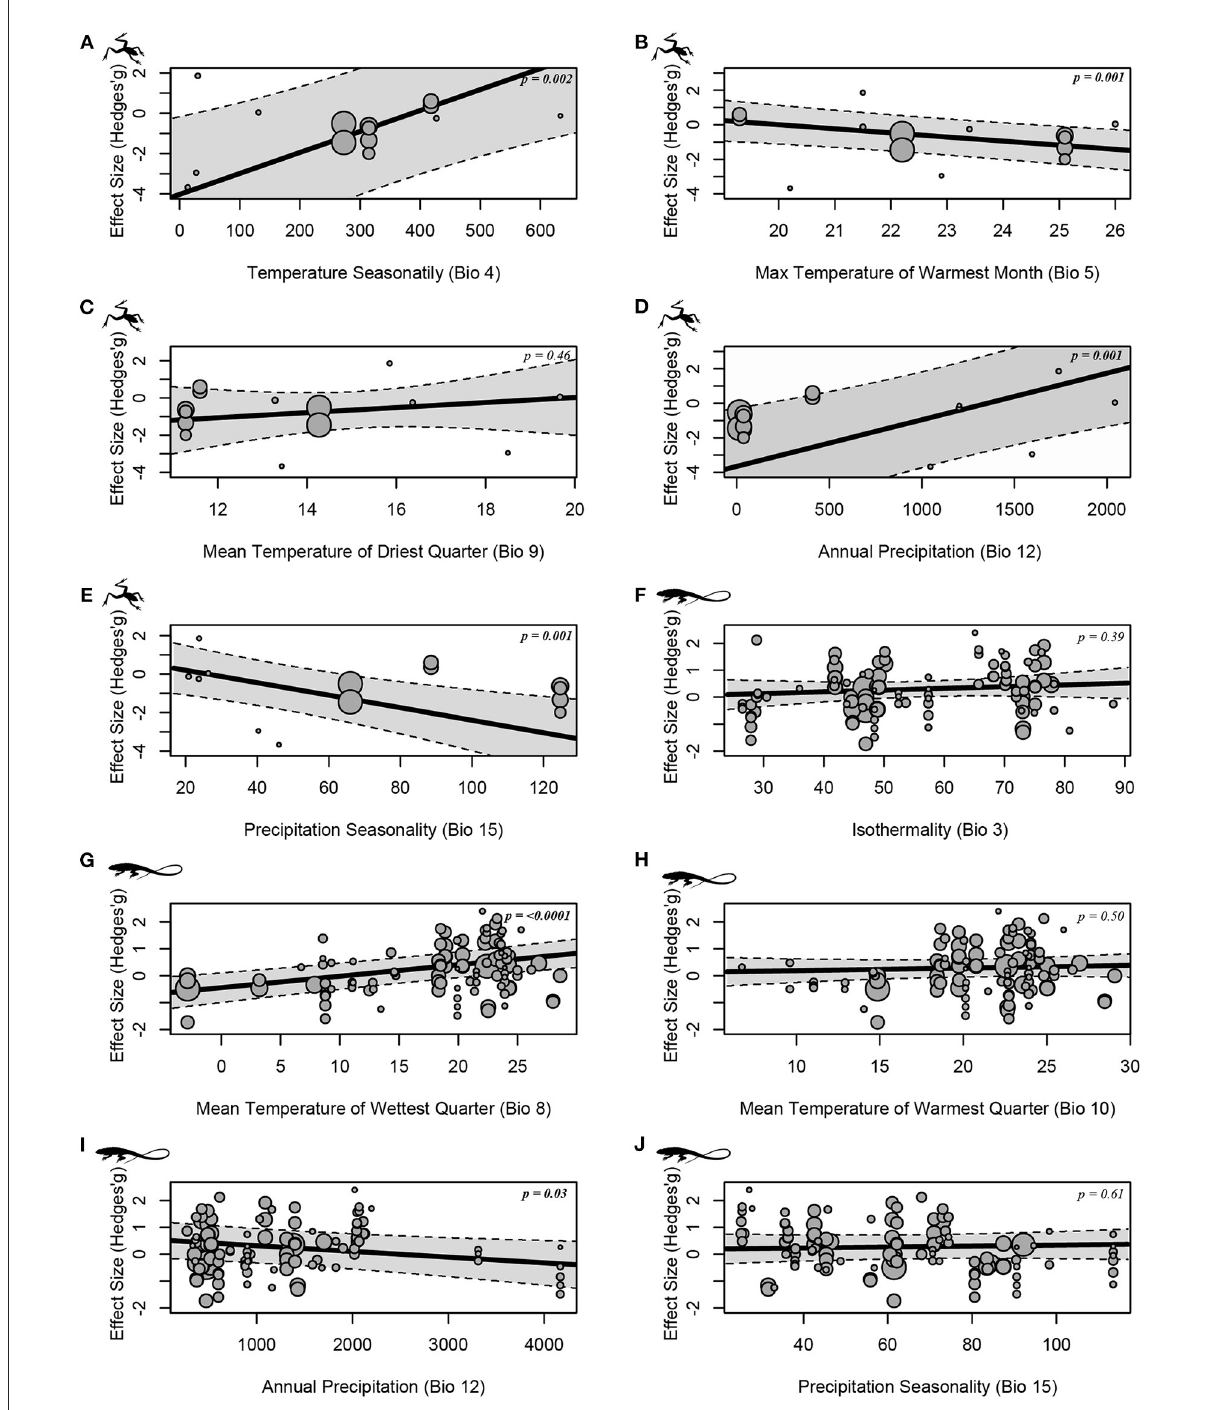
FIGURE3 Effect size on the influence of altitudinal climatic variation to the CTMax in anurans (A–E) and lizards (F–J) . Circle size denotes the precision of each estimate–larger circles representing more accurate estimates. The P-value ( p) from each analysis is available inside the charts.